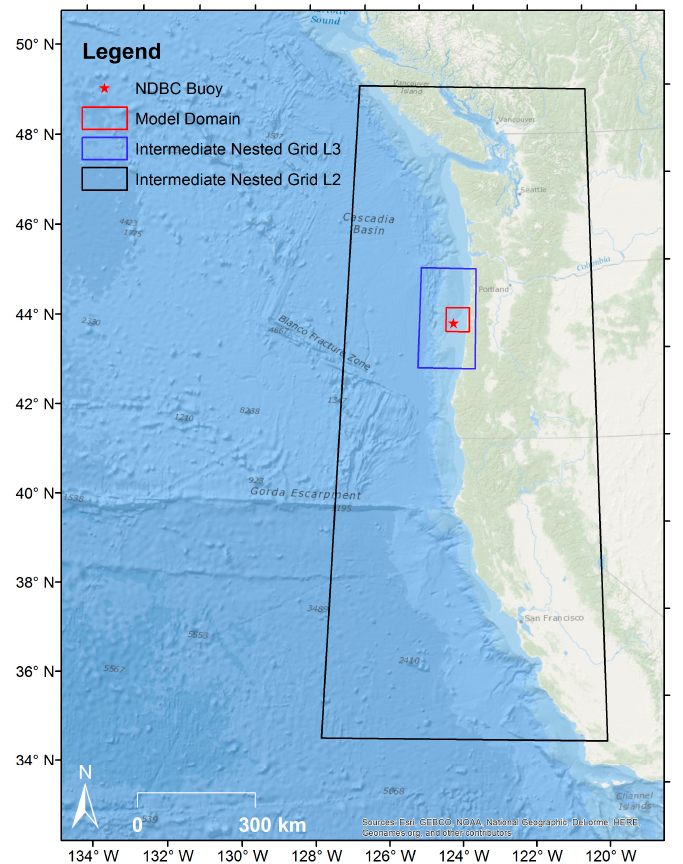
Figure 1. The UnSWAN model domain (red box) off the central Oregon coast, along with the location of the National Oceanic and Atmospheric Administration National Data Buoy Center (NDBC) Buoy 46050. The nested WWIII model domains include a global grid (L1, not indicated on the map) and two intermediate grids (L2 and L3).